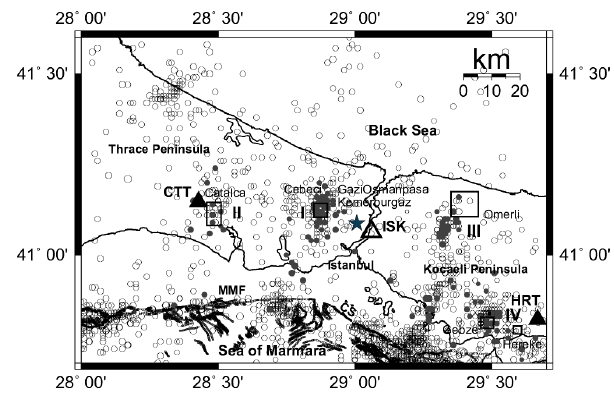
Fig. 1. Map showing the study area (40.70–41.60 ◦ N latitude Fig. 1 Map showing the study area (40.70-41.60oN latitude and 28.00-29.70oE longitude) and locations and 28.00–29.70 ◦ E longitude) and locations of seismic events of seismic events used for statistical analysis of the seismicity catalogs (KOERI-NEMC) for 1995-2007 (first 8 months) marked by open black circles and locations of seismic events with duration magnitude used for statistical analysis of the seismicity catalogs (KOERI- between 1.8 and 3.0 (filled black circles) used for waveform of digital data for vertical seismograms NEMC) for 1995–2007 (first 8 months) marked by open black recorded at ISK broad-band station (open triangle) and CTT and HRT short-period (filled triangles) circles and locations of seismic events with duration magni- stations (KOERI-NEMC, 2001-2004). Boxes show the quarry sites (I: Gaziosmanpaşa/Cebeci and tude between 1.8 and 3.0 (filled black circles) used for wave- Kemerburgaz, II: Çatalca, III: Ömerli, IV: Hereke) determined from satellite images (Musaoğlu et al., form of digital data for vertical seismograms recorded at ISK 2004) and field observations. Filled black star shows the location of 20th November 2005 explosion. broad-band station (open triangle) and CTT and HRT short-period MMF, Main Marmara Fault; ÇS, Çınarcık segment of the MMF (from Horasan et al., 2009). (filled triangles) stations (KOERI-NEMC, 2001–2004). Boxes show the quarry sites (I: Gaziosmanpas¸a/Cebeci and Kemerburgaz, II: C¸atalca, III: ¨Omerli, IV: Hereke) determined from satellite im- ages (Musaoˇglu et al., 2004) and field observations. Filled black star shows the location of 20 November 2005 explosion. MMF: Main Marmara Fault; C¸S: C¸ınarcık segment of the MMF (from Horasan et al.,